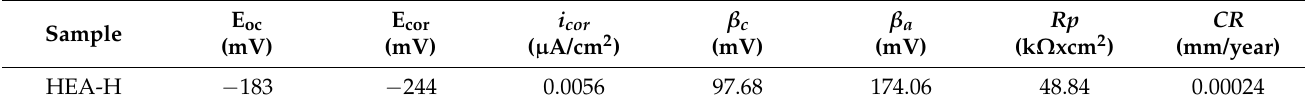
Figure 5. Tafel plot for HfNbTaTiZr HEA. (HEA-H). Table 4. Corrosion resistance parameters for the HfNbTaTiZr HEA